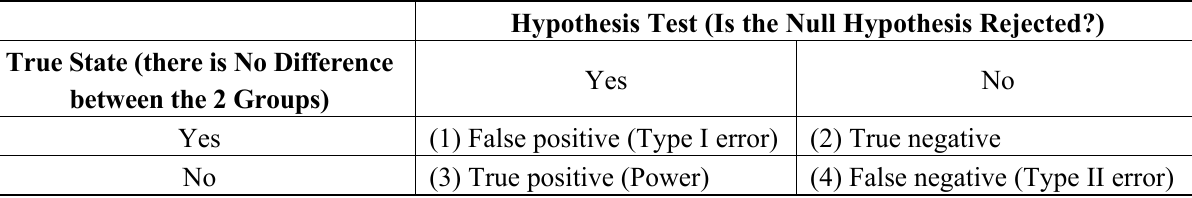
Hypothesis Test (Is the Null Hypothesis